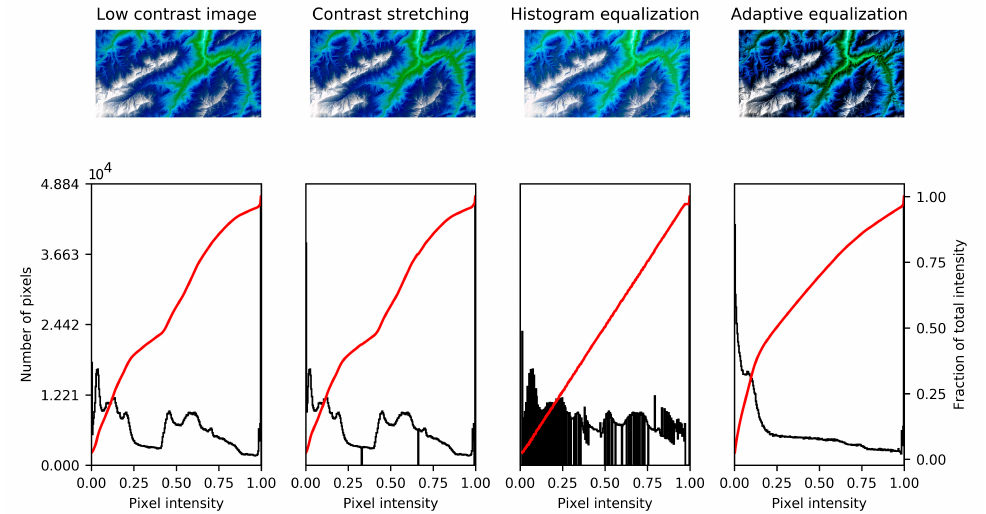
Figure 9. Pixel grid cells intensity evaluations during processing of images.